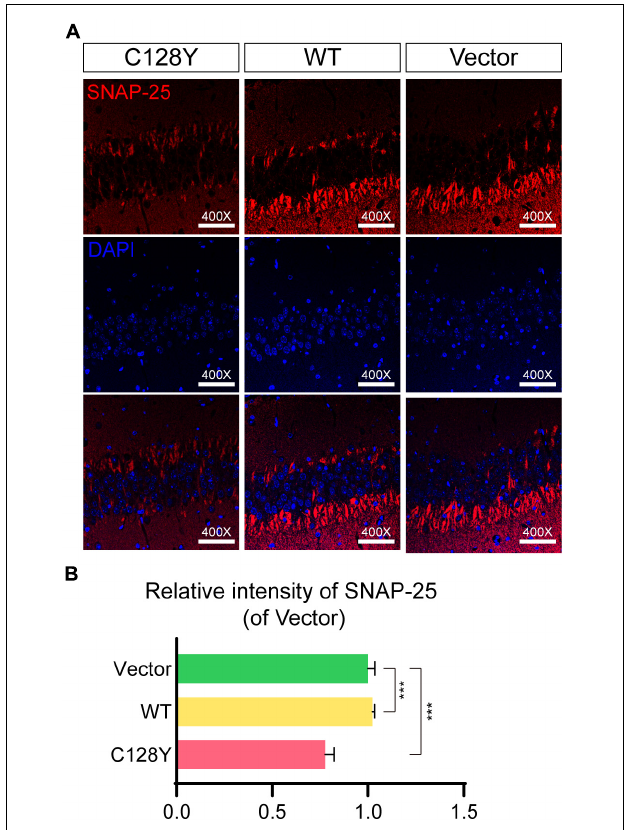
FIGURE 5 | Changes of SNAP-25 expression in hippocampal CA3 region due to C128Y mutation. (A) Representative pictures show the decrease of SNAP-25 in the hippocampal CA3 region of mice expressing C128Y mutant CSP α , as quantified in panel B . N = 3, all data in the figure are shown as mean ± SEM, each group vs. vector. * P < 0.05, ** P < 0.01, *** P < 0.001, and **** P <